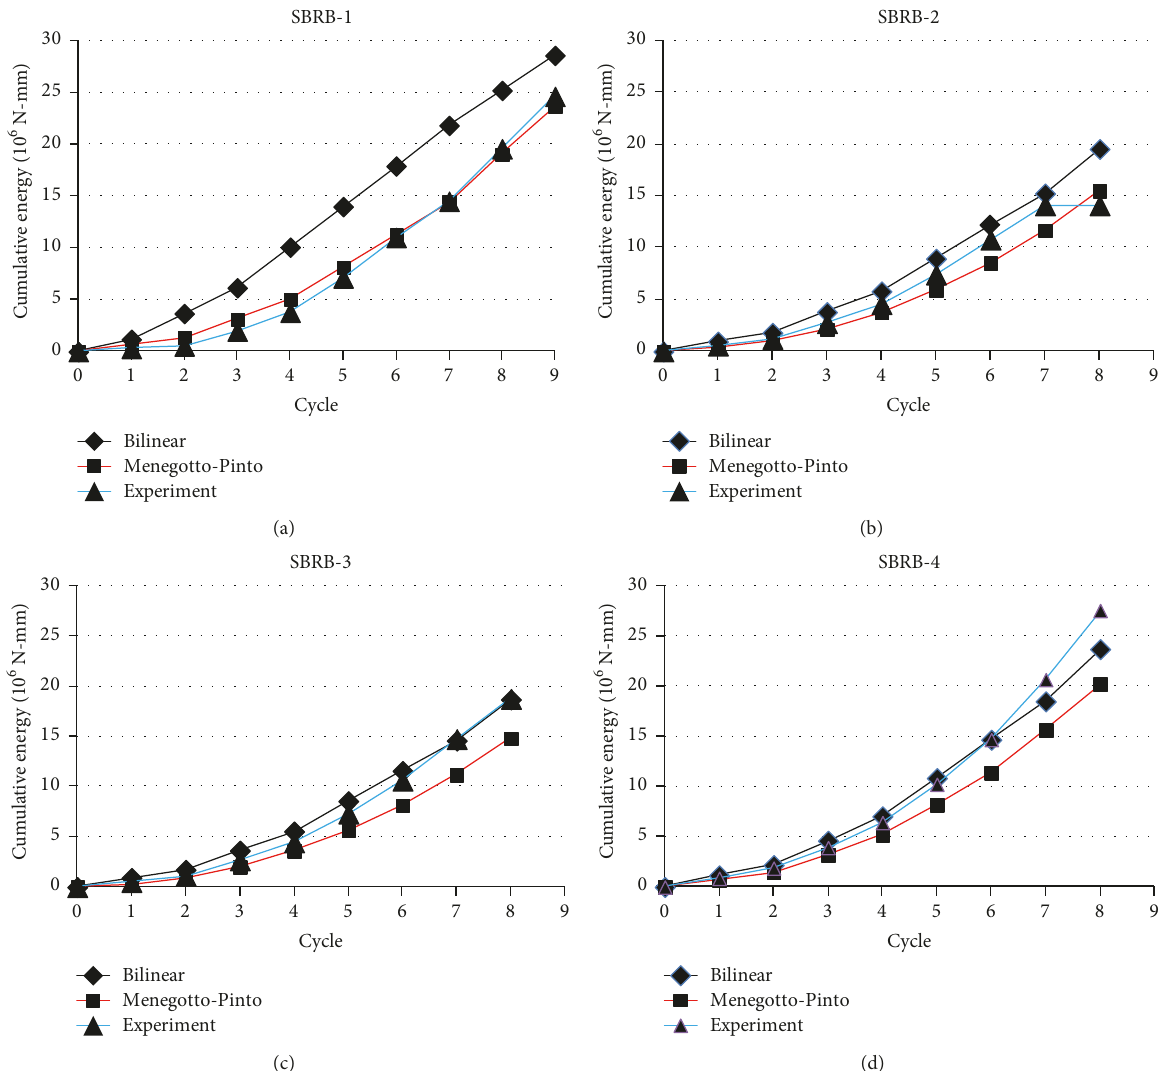
Figure 13: Comparisons of analytical cumulative energies by bilinear DRAIN-2DX, Menegotto-Pinto function, and experimental cumulative